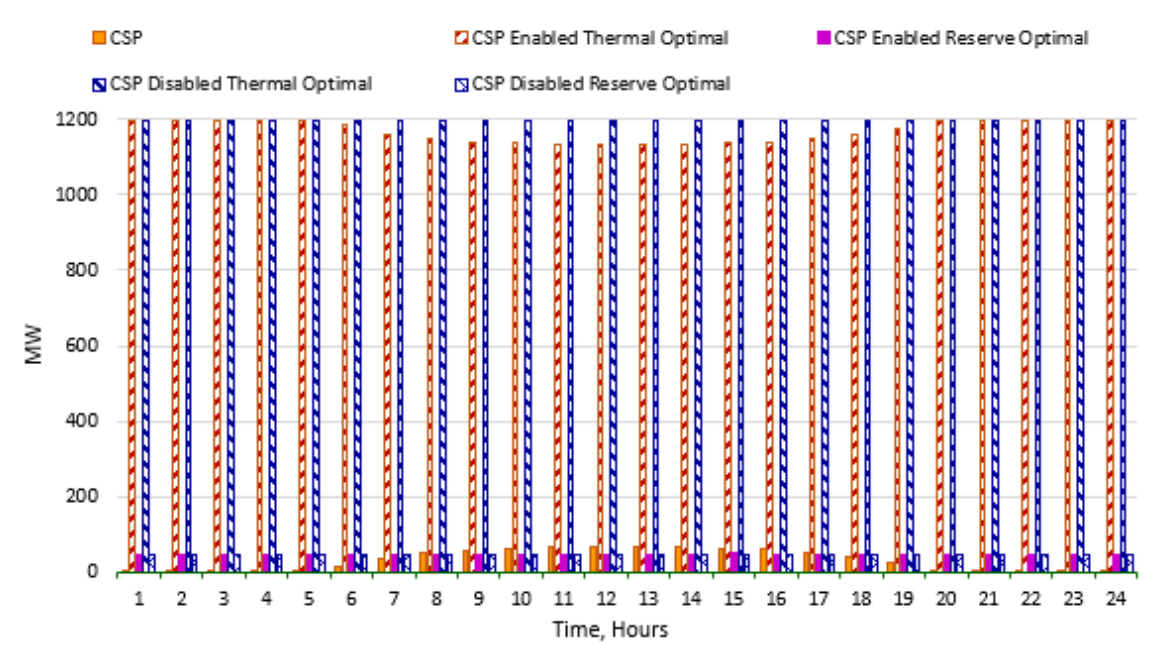
Figure 9. Balance of powers in Scenario 1 (hybrid system with CSP enabled) and Scenario 2 (thermal system with CSP disabled), during 24 h.